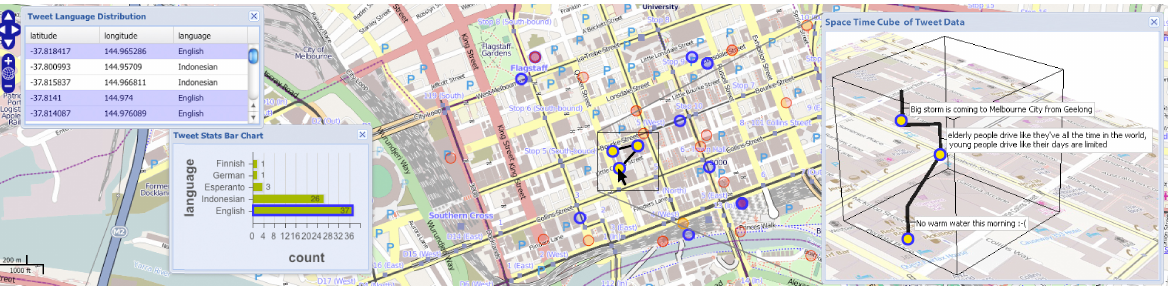
Figure 2. An example of tweets with the Melbourne Central Business District (CBD) dynamically visualised via linked maps, graphs and a Space Time Cube, where multiple views can be dynamically interrogated through a GIS and Cartographic brushing